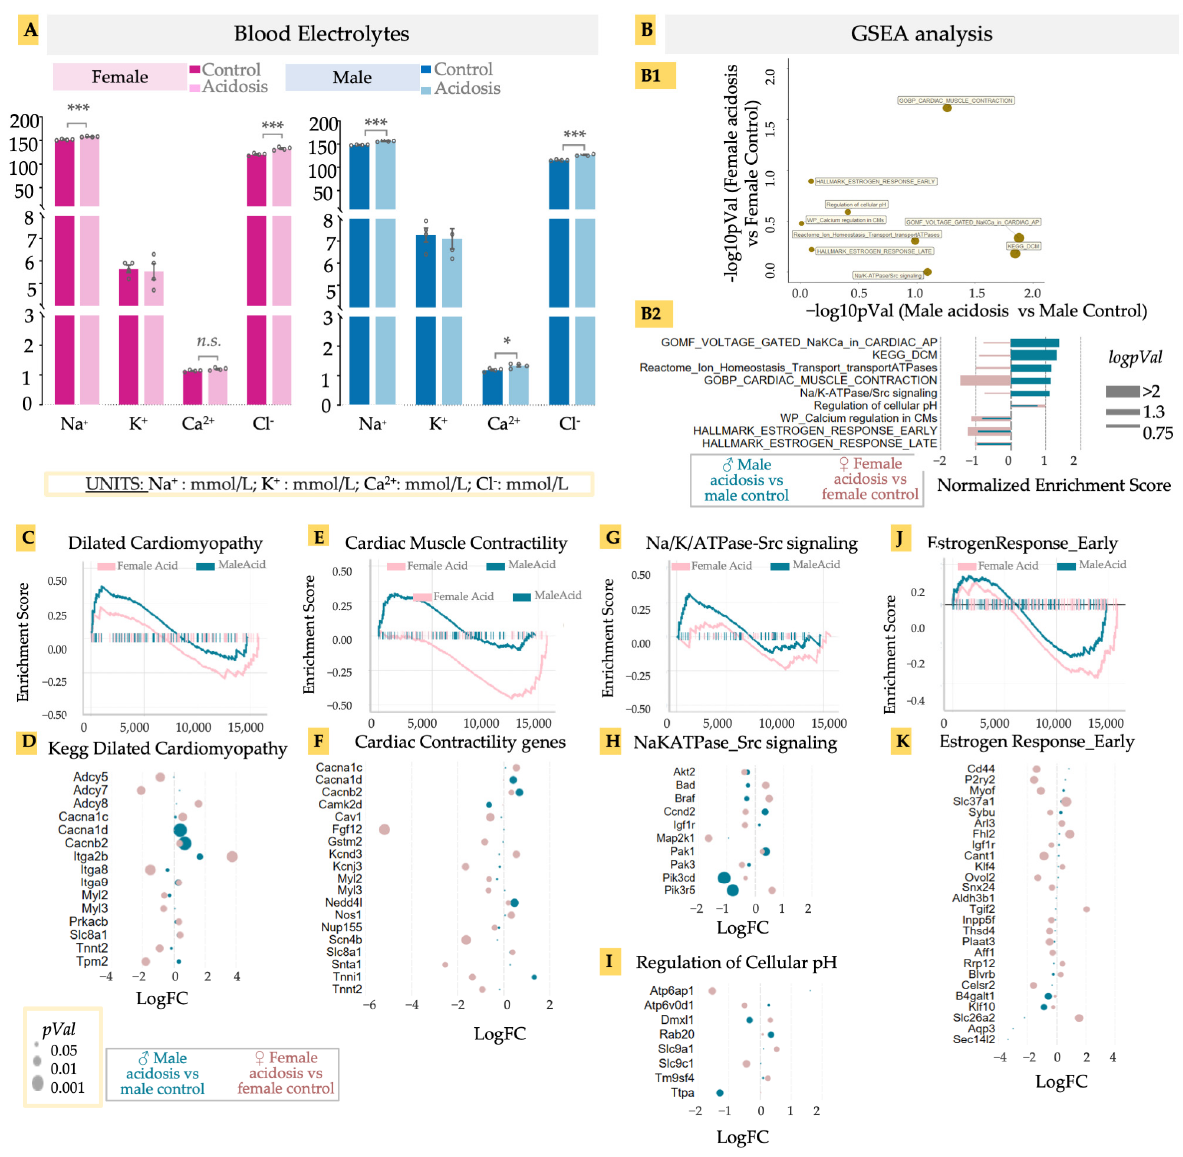
Figure 4. ( A ) Blood electrolytes. Acidosis compared to control; two-tailed student’s t -test was used to determine the significance. * < 0.05; *** < 0.001; n.s. (non-significant). Sodium (Na, mmol/L), potas- sium (K, mmol/L), calcium (Ca, mmol/L), chlorine (Cl, mmol/L). ( B ) GSEA analysis of differentially expressed genes in male and female acidosis models, ( B1 ) Targeted GSEA analysis and negative logpVal of relevant/cardiac ontologies. ( B2 ) enrichment scores of the relevant/cardiac ontologies in GSEA analysis. GSEA and bubble plot of differentially expressed genes in DCM ontology ( C , D ), Cardiac muscle contractility ( E , F ), and Na/K/ATPase-Src signaling ( G , H ). Bubble plot of differential genes in regulation of cellular pH ( I ). GSEA and bubble plot of differentially expressed genes in estrogen response early ontology ( J , K ). GSEA and bubble plots are color coded with male acidosis vs. male control (blue) and female acidosis vs. female control (pink). Size of bubble or bar plot is determined with either pVal ( p -value), logpVal or −− log10 of pVal.